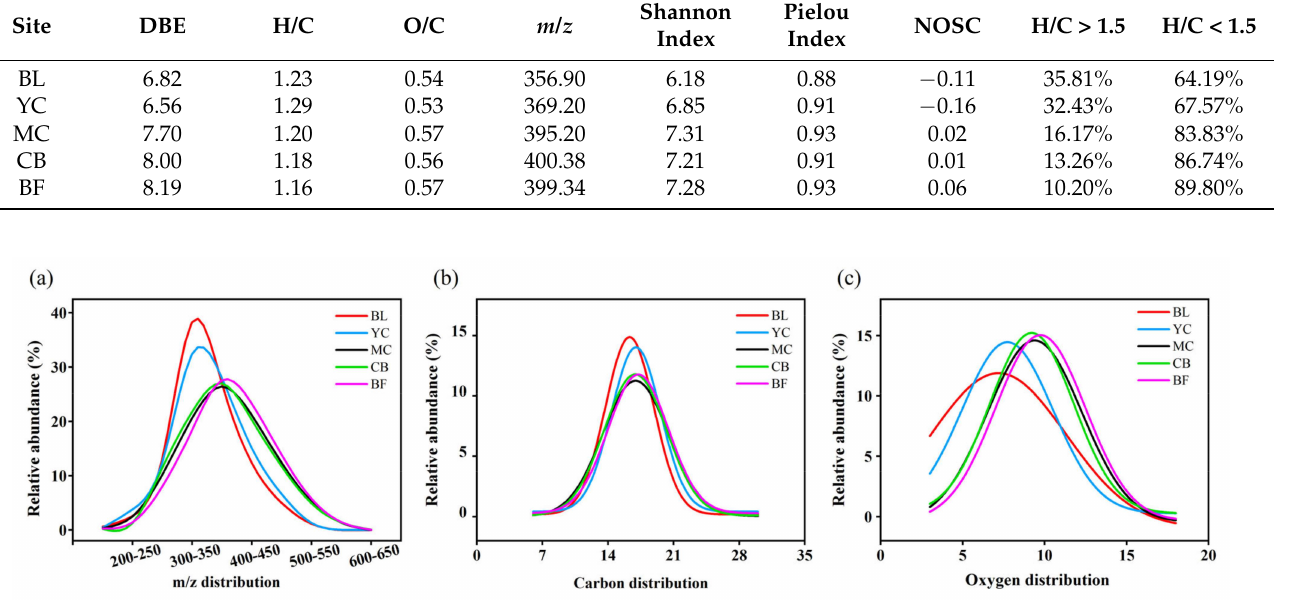
Figure 3. Characteristics of dissolved organic matter molecules in soil samples from sites of different forest types, BL, YC, MC, CB, and BF. The distribution of the mass-to-charge ratio ( m / z ) ( a ), the distribution of Cx class species ( b ), and the distribution of Ox class species ( c ). BL: bare land; YC: newly restored young coniferous forest; MC: slightly more mature coniferous forest; CB: mixed coniferous and broadleaf forest; BF: broad-leaved